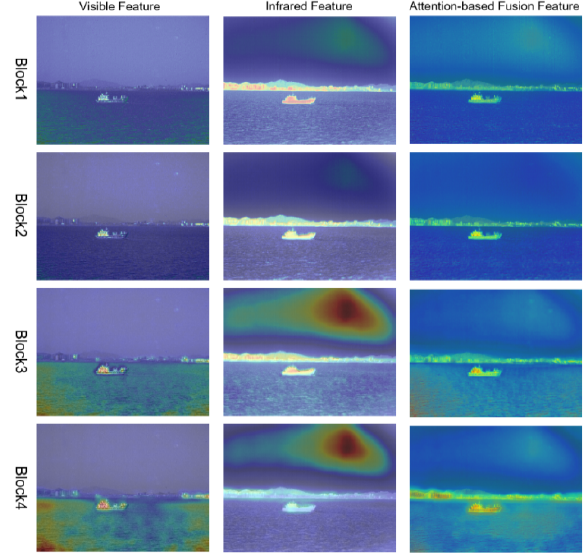
Figure 6. A visualization of the effectiveness of our attention fusion module.